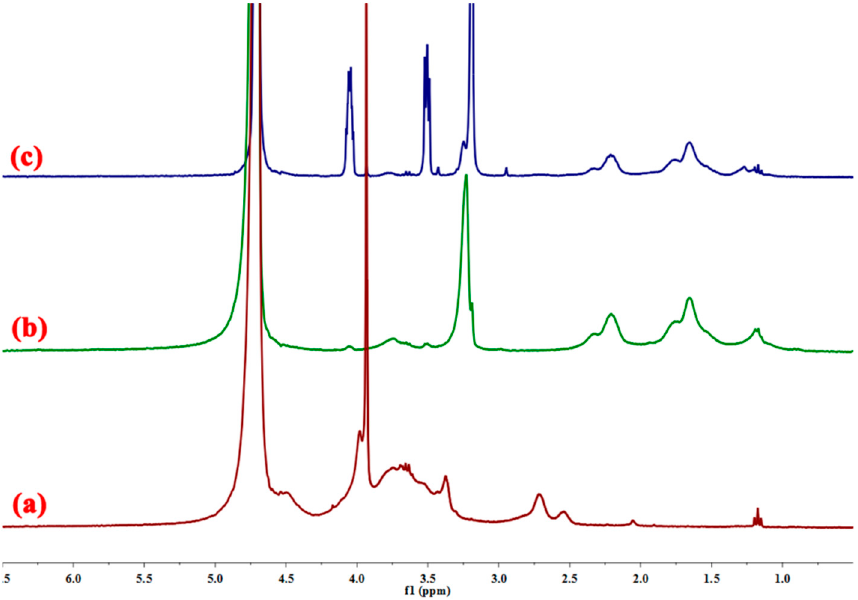
Figure 3. 1 H-NMR spectra of ( a ) CMCS, ( b ) P(AM-DMC), and ( c ) CCPAD.